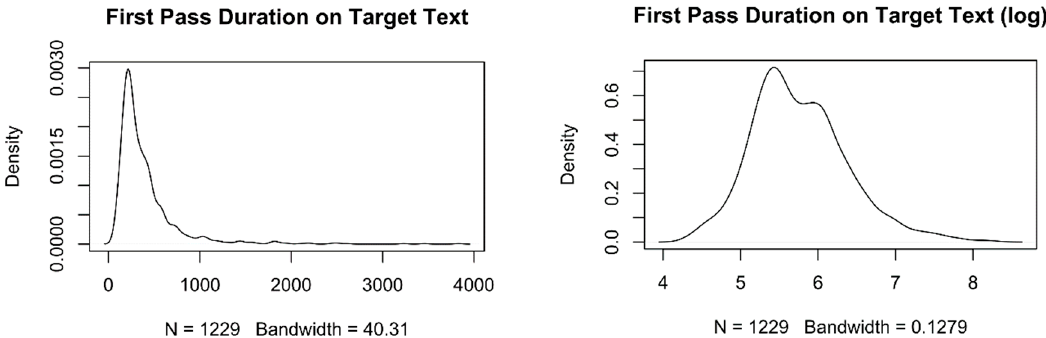
Figure 13. Density plot ( left ) and log-transformed density plot ( right ) for source text first pass duration.